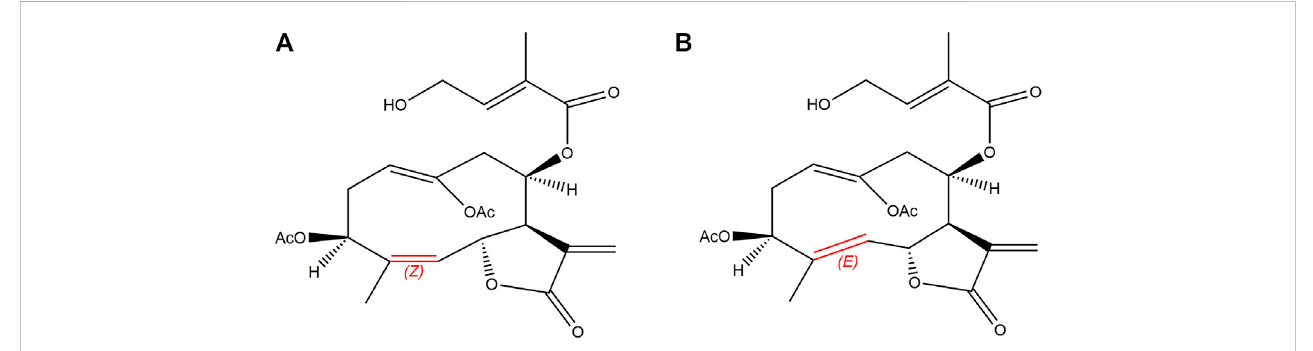
FIGURE 1 Chemical structures of EA [ (A) ; Z-con fi guration] and EB [ (B) ; E-con fi